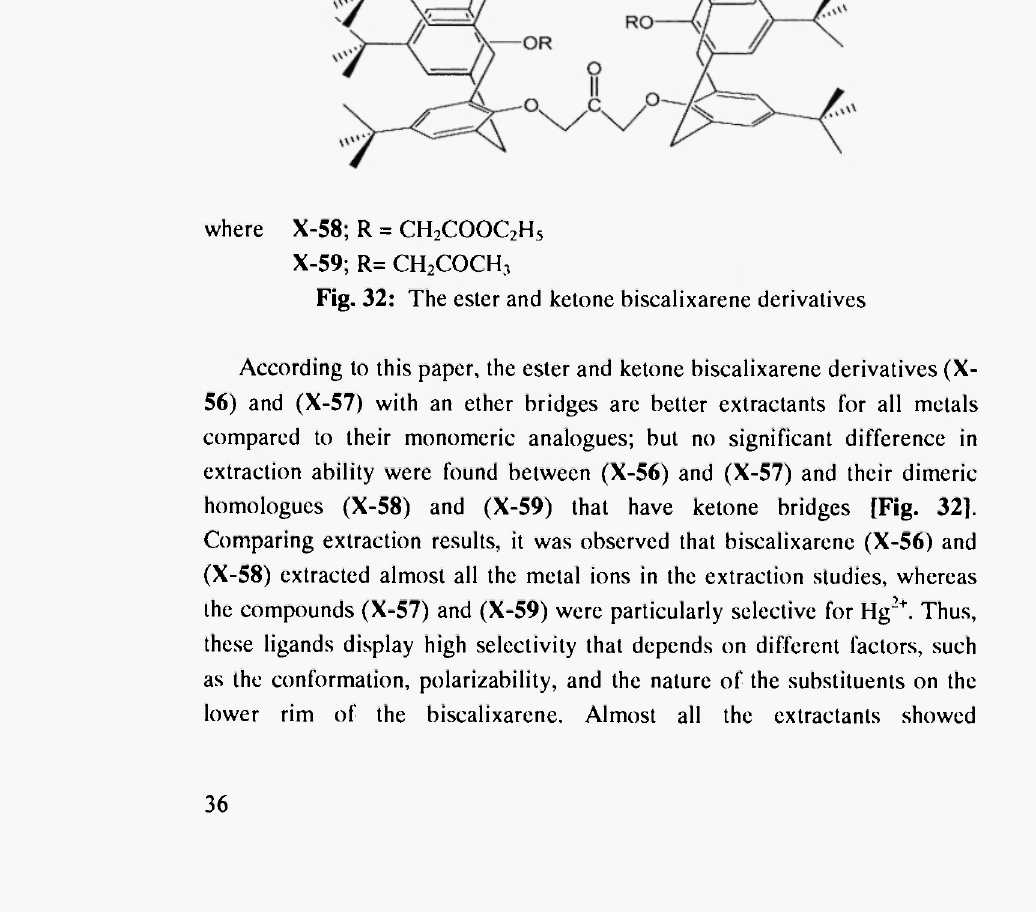
Fig. 32: The ester and ketone biscalixarene derivatives